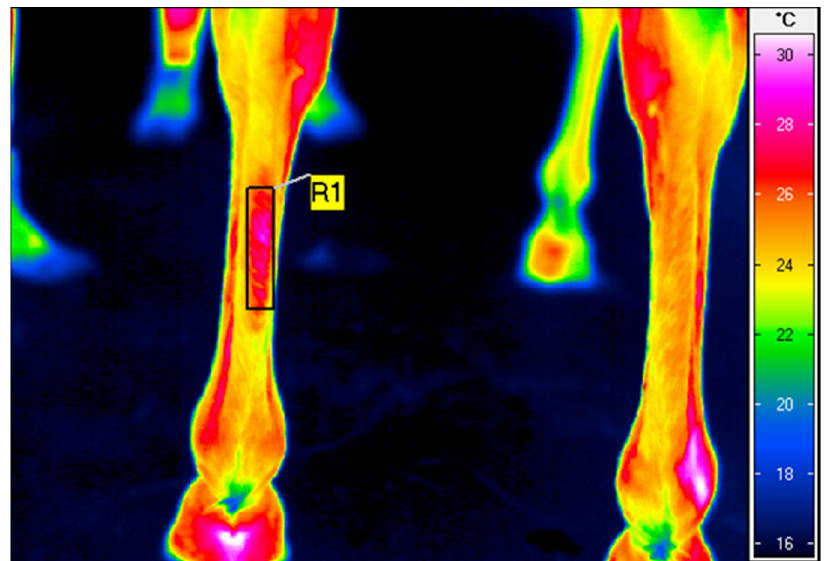
Figure 1. A thermographic image of the plantar aspect of the middle one-third of the third metatarsal bone of the left hindlimb in the superficial flexor tendon region, taken after high-intensity laser therapy application. The rectangular area (R1) indicates an average body surface temperature of 26.3 ◦